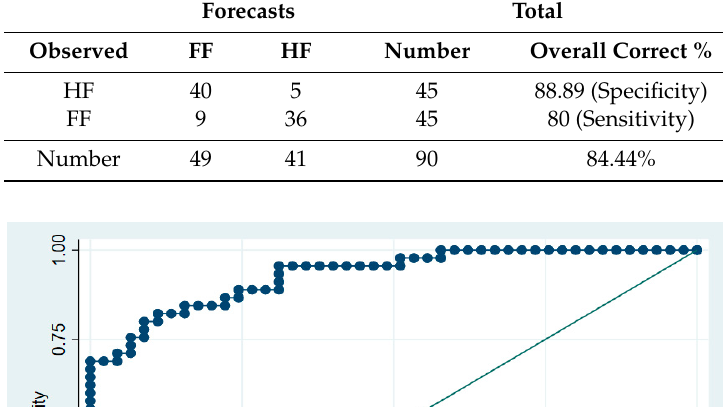
Table 10. Regression results one year before